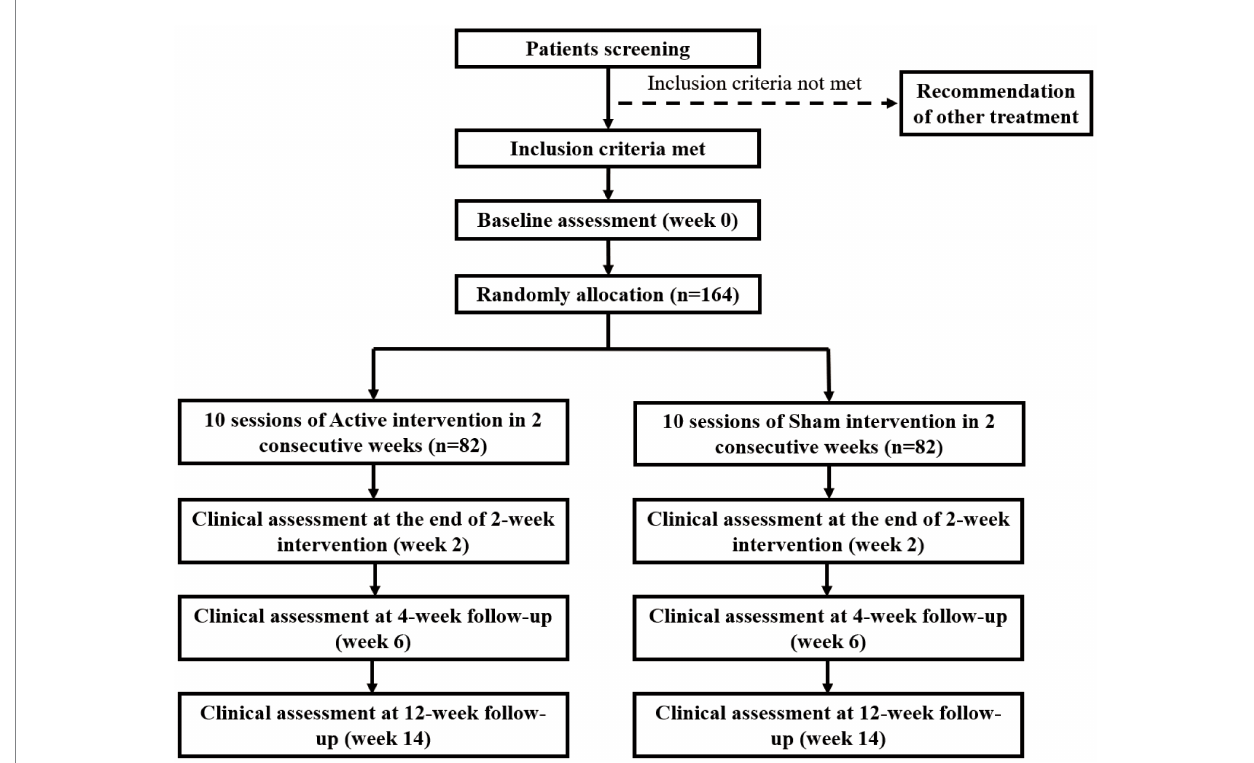
FIGURE 1 Design and flow of participants through the